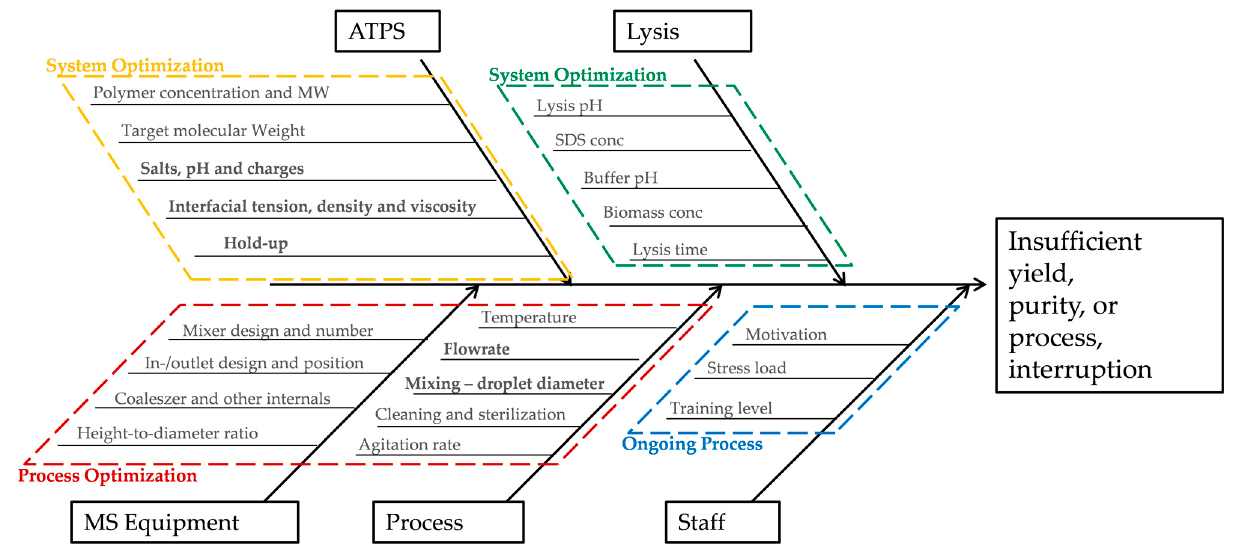
Figure 20. Ishikawa diagram of the possible process disturbances of ATPE and lysis.